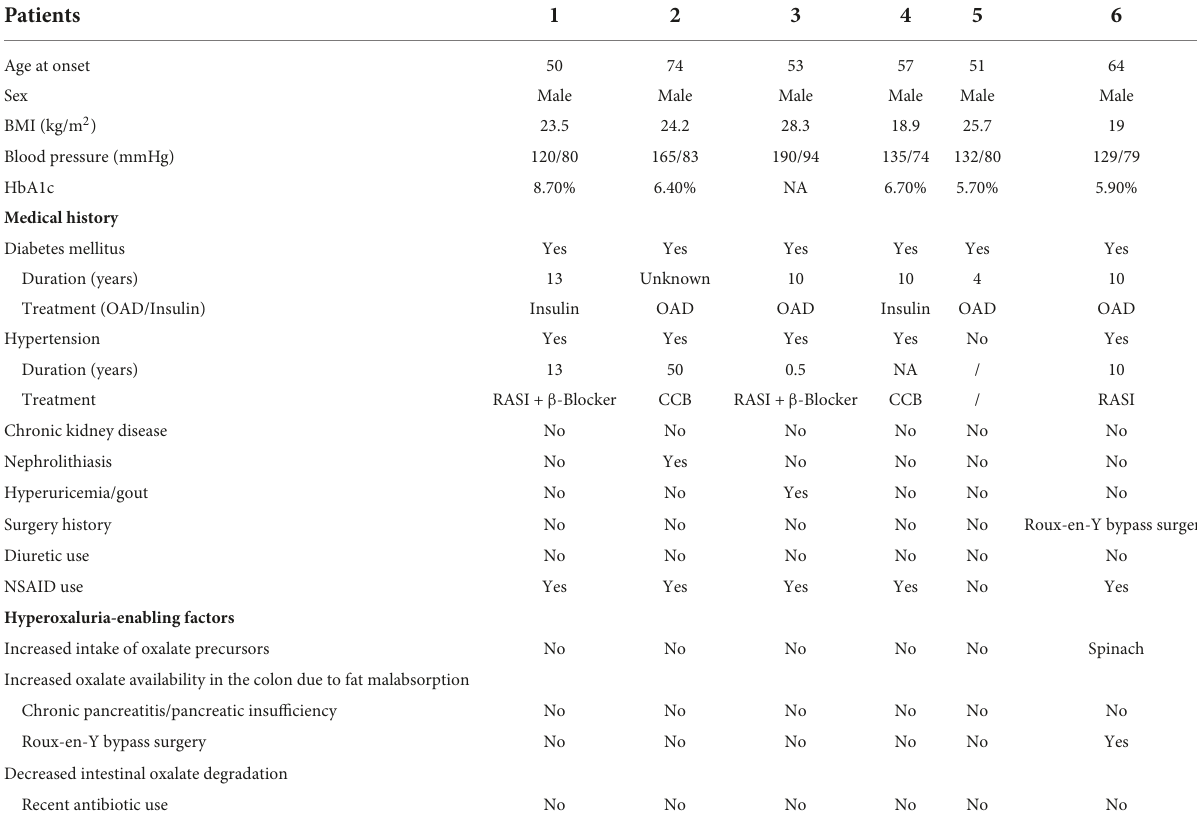
TABLE 1 Demographic, clinical features and potential hyperoxaluria enabling factors of 6 patients with acute oxalate nephropathy. Patients